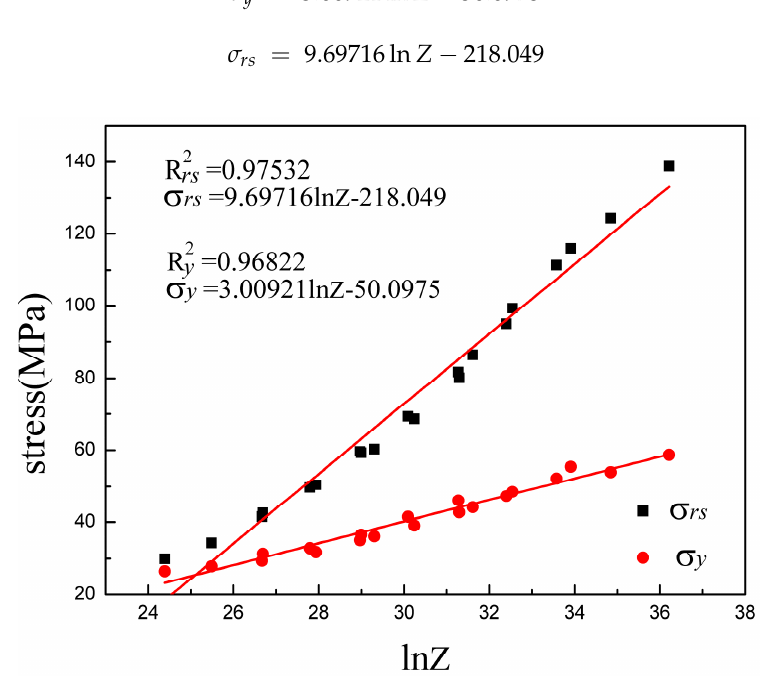
σ Z parameter and ds . The linear curve is got from linear fitting.